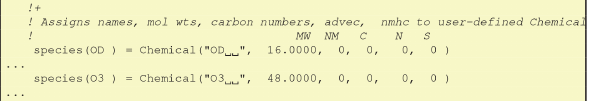
Figure 10. Selected lines from the species array defined in the GenChem-produced file CM_ChemSpecs_mod.f90 .